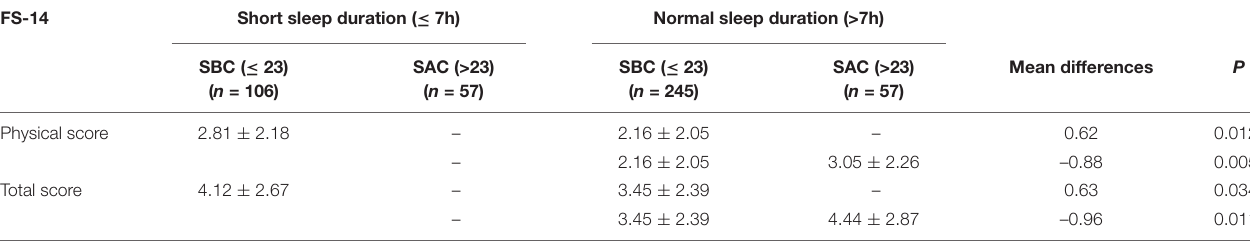
TABLE 3 | The interaction of sleep duration and bedtime on the 14-item Fatigue Scale (FS-14) scores. FS-14 Short sleep duration ( ≤ 7h)